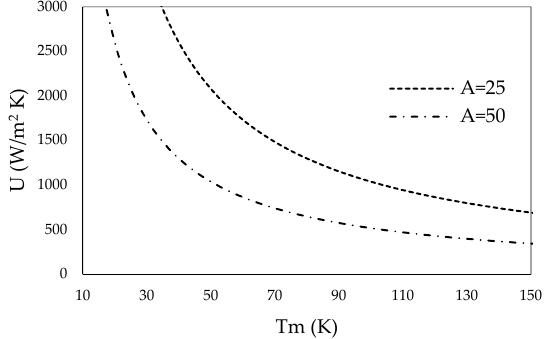
Figure 3. Total heat transfer coefficient for one segment (A = 25 m 2 ) and two segments (A = 50 m 2 ) over the mean temperature difference.